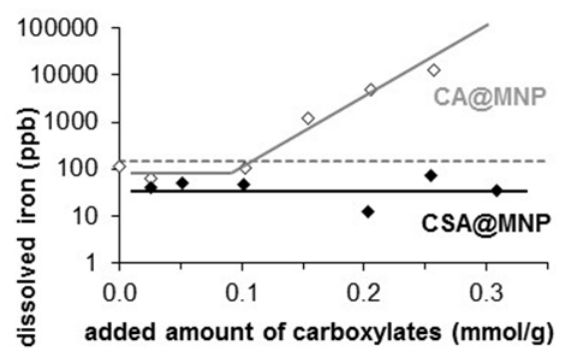
Figure 7. Dissolved iron concentration in CA@MNP and CSA@MNP dispersions (in 10 mM NaCl solution at pH ~6.3) in the function of the added amount of carboxylates, such as citric acid (CA) [22] and CSA. (The lines are drawn to CA and CSA data to guide the eyes. The dotted line indicates the detection limit of iron).